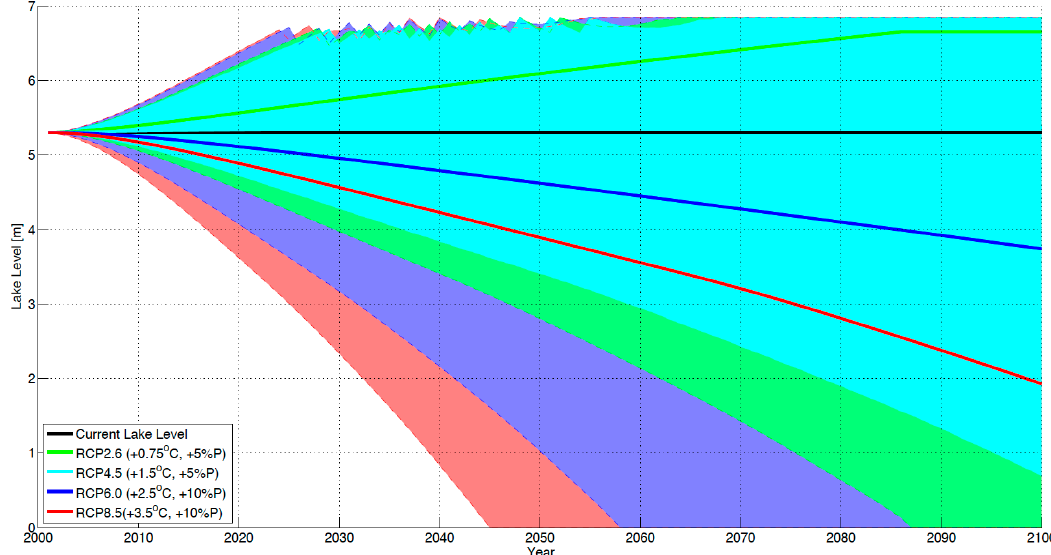
Figure 9. Lake Babati response to climate change scenarios. The thick solid lines represent lake response to ensemble mean change in precipitation and temperature; the shaded areas represent the one standard deviation confidence range for each scenario; bounded with thin dashed lines of the same color as the mean response lines.